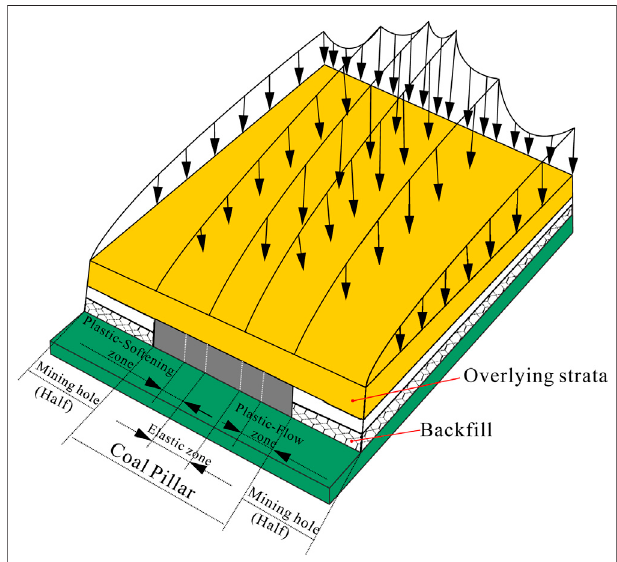
FIGURE 1 | Models of the elastic zone, plastic-softening zone, and plastic- fl ow zone of the coal pillar.